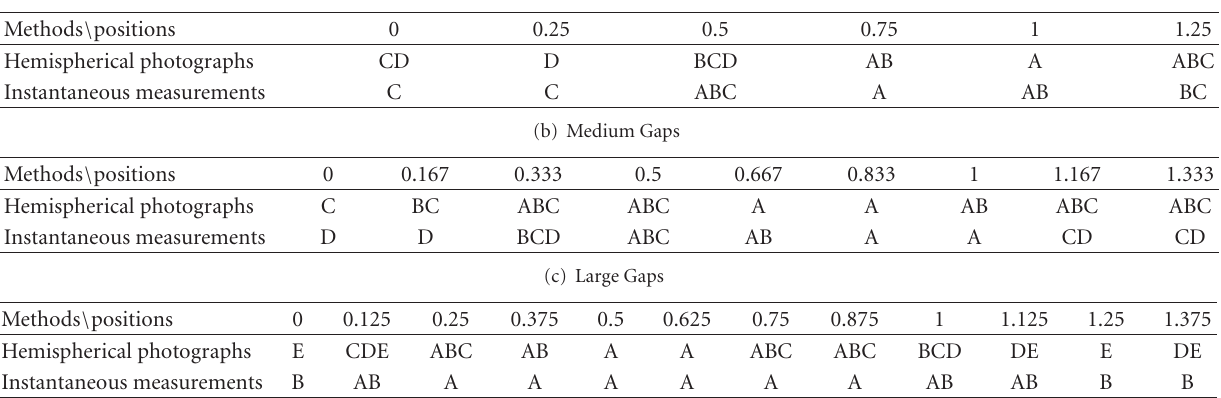
Table 1: Results of the Tukey-Kramer post-hoc test for both methods (hemispherical photographs and instantaneous measurements) and gaps of di ff erent ratio: (a) small gaps with D/H ratio ≤ 0 . 5, (b) medium gaps with D/H ratio = 1 ± 0 . 25, and (c) large gaps with D/H ratio